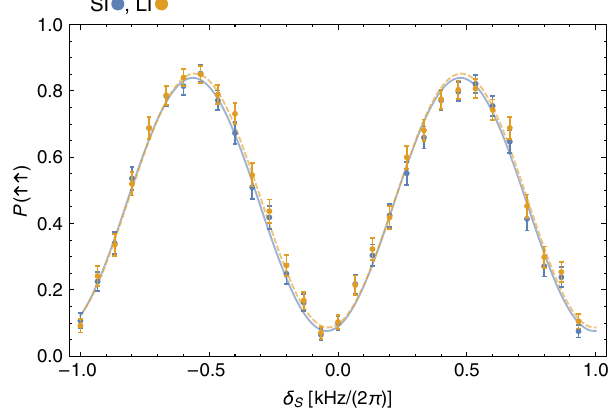
FIG. 2. Spin populations for the four-ion chain LI-SI-SI-LI (SI, blue; LI, orange), initially prepared in the spin state j ↑ LI ↑ SI ↑ SI ↑ LI i , performing Ramsey spectroscopy with free evolution time T R ¼ 500 μ s. The data show the same Ramsey- fringe oscillation frequency as the LI-SI data with T R ¼ 1 ms, consistent with Heisenberg scaling. We fit sinusoids to the LI-LI and SI-SI data [displayed in matching colors with solid (dashed) curves for fits to SI (LI) data] and extract a contrast of 75(2)% for the LI data and a phase shift between the LI-LI and SI-SI data ≈ 64 μ s. Error bars of Δ ϕ ¼ 0 . 03 ð 3 Þ . In this experiment, t MS (1 sigma) are calculated assuming quantum projection noise only. Each data point represents the average outcome of 200 repetitions of the